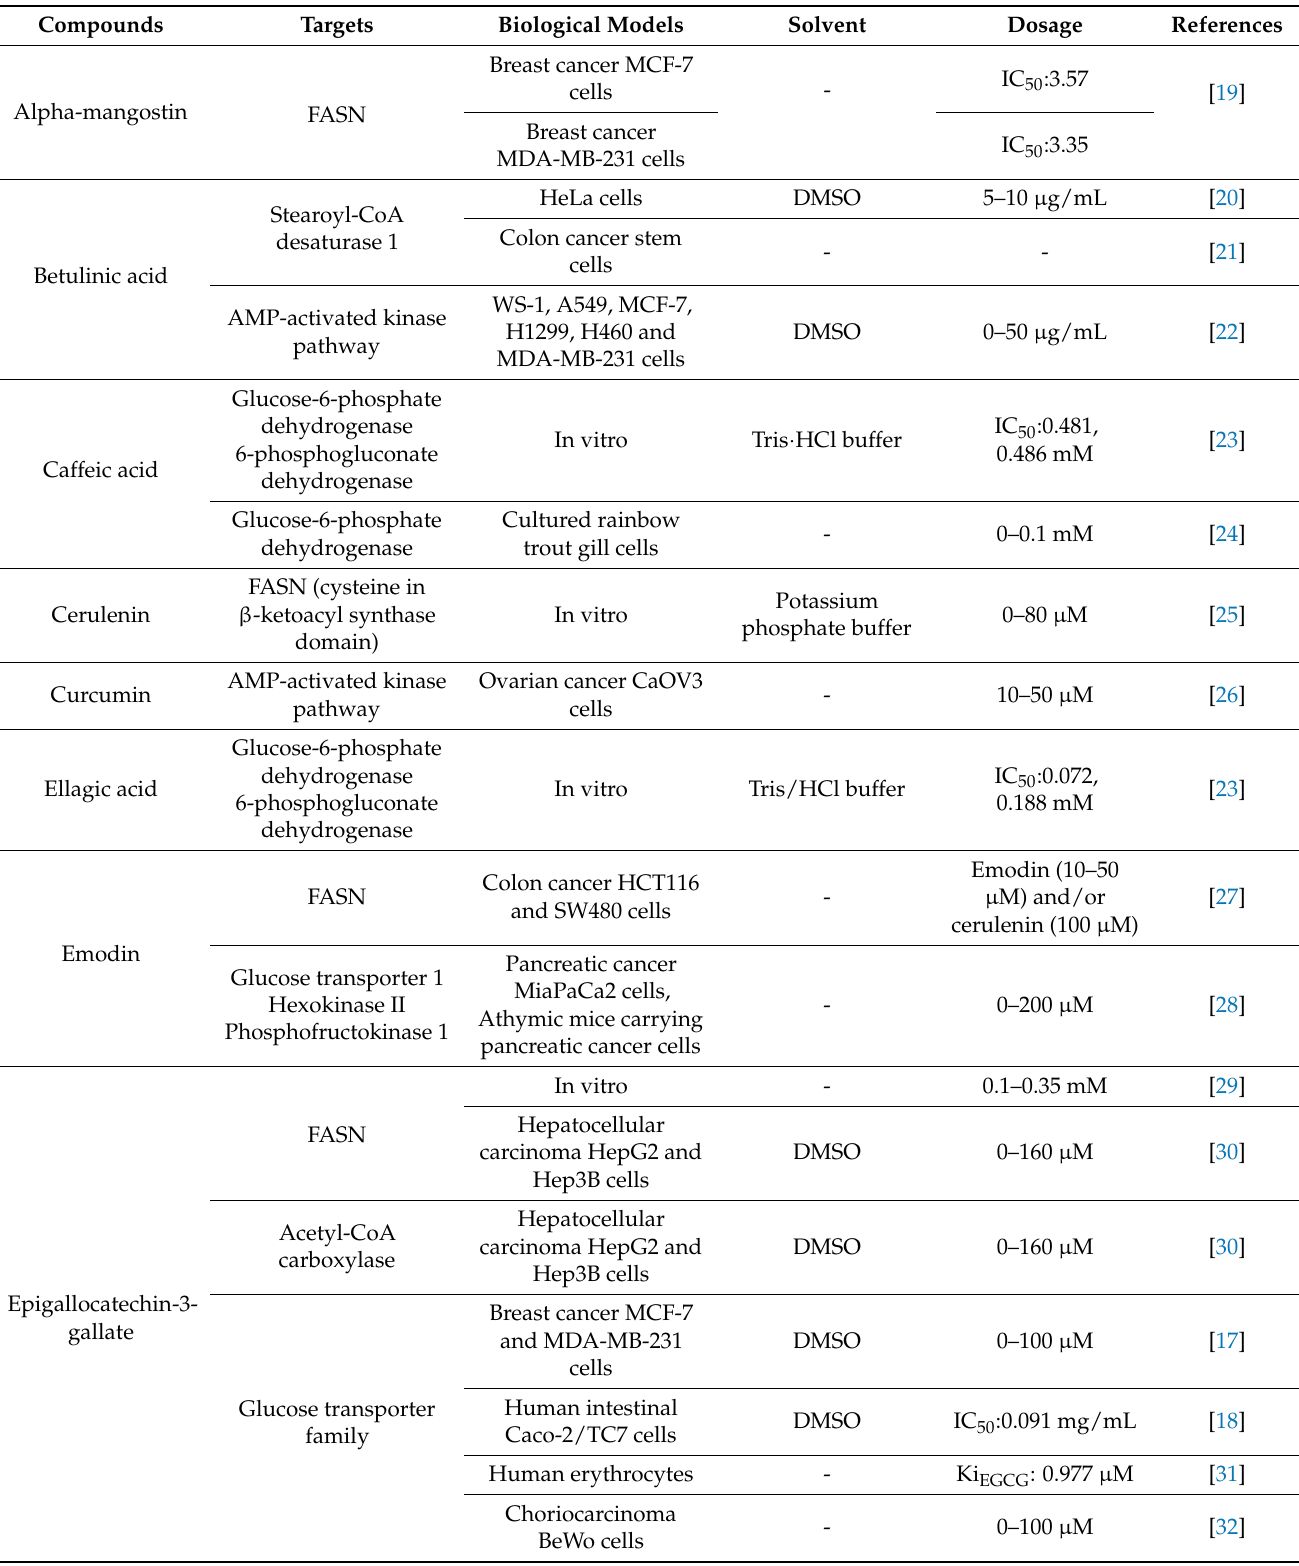
Table 1. Naturally occurring compounds reported as metabolic antagonists in cancer glucose utilization and lipogenesis. Discussed in this